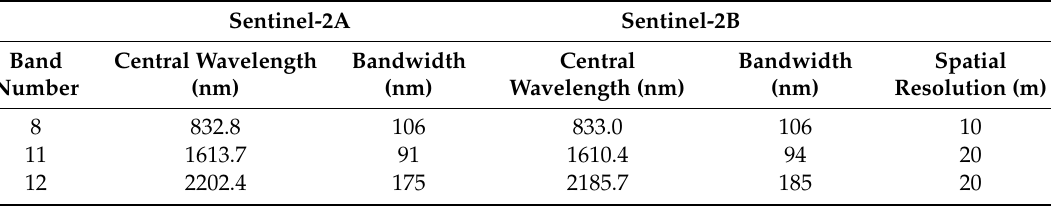
Table 2. A summary of bands in classification feature set, including their central wavelength, bandwidth, and spatial